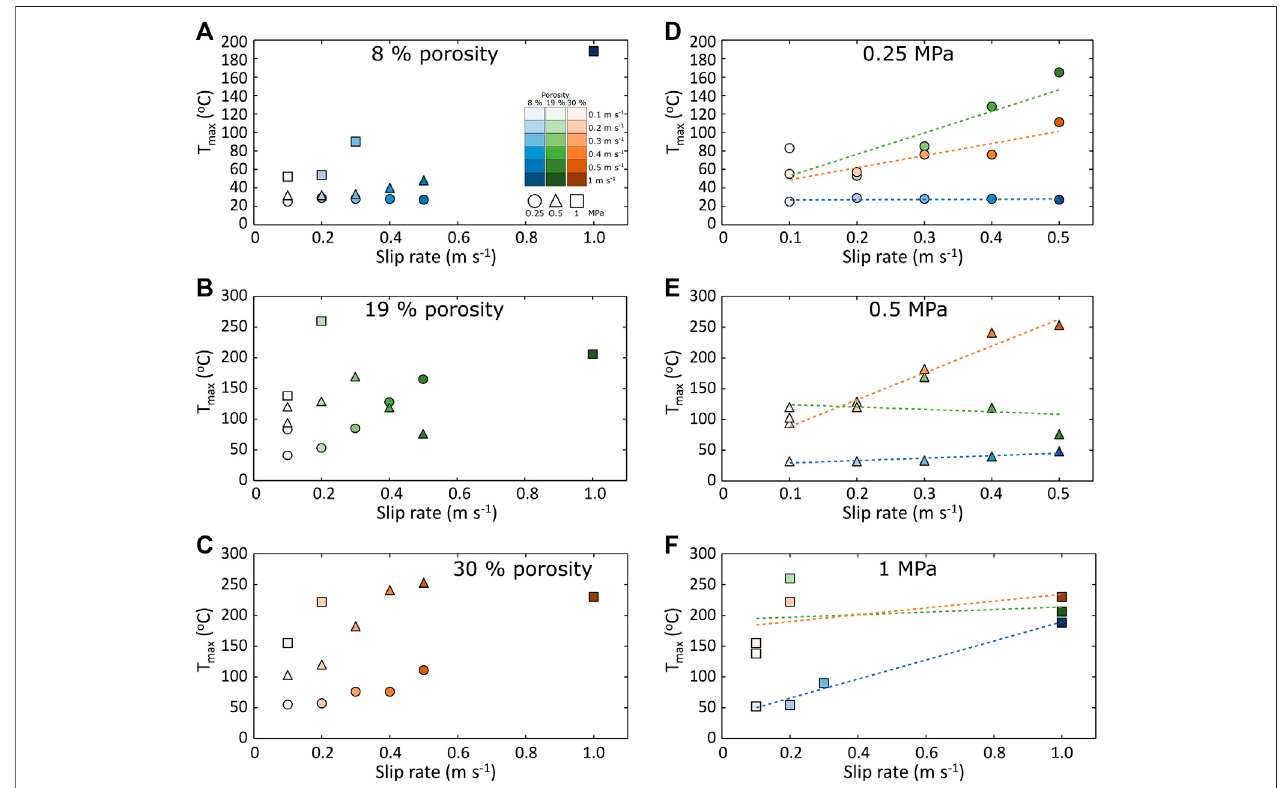
FIGURE 5 | Maximum temperature ( T max ) achieved during slip as a function of slip rate. (A – C) The effect of normal stress (0.25, 0.5 and 1.0 MPa) for each of the sampleporosities tested,showinghigher T max athigher sliprateandat highernormalstress. (D – F) Theeffectofporosity (8,19and30%)at each ofthenormal stresses, showing increasing T max with increasing slip rate for all porosities, but a complex impact of porosity on T max , where 19% porosity samples result in higher maximum temperatures than 30% porosity. Note that T max may occur at different slip distance for each test, a complete temperature record of all experiments is provided in the Supplementary Material .